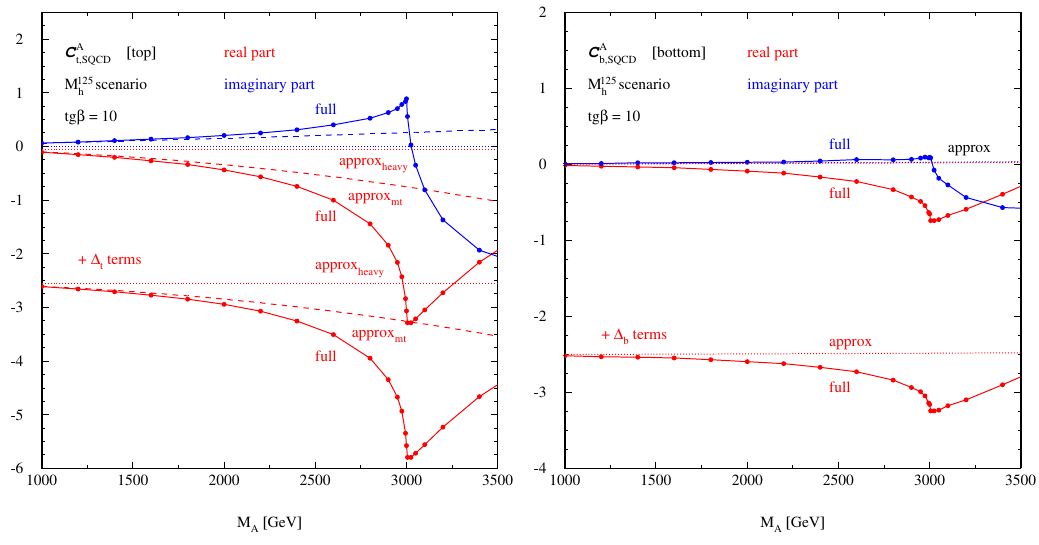
Figure 6 . The genuine SUSY-QCD corrections to gg → A normalized to the LO top and bottom quark form factors for tg β = 10 in the M 125 benchmark scenario. Real part: red, imaginary part: h blue, compared to the approximate calculations of ref. [75] (dashed lines). The dotted lines for the stop contributions correspond the combined limit of large top and SUSY masses.